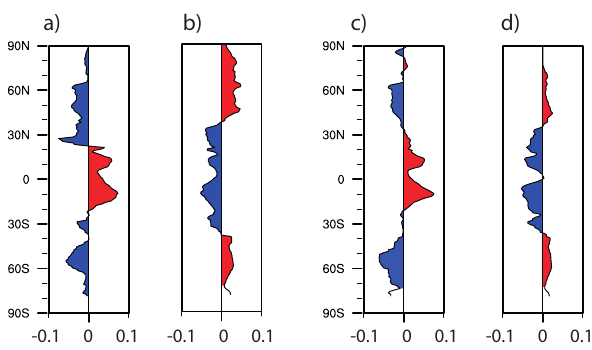
Fig. 5. Zonal mean changes in (a) light and (b) nutrient limitation of diatoms and (c) light and (d) nutrient limitation of small phyto- plankton. The limitation factor is a unitless value between zero and one, with zero representing maximal limitation and one represent- ing unlimited growth. An increase in limitation factor leads there- fore to an increase in growth. For this plot, changes in the limitation factor have been calculated for each cell as described in Sect. 2.5, and the zonal means of the resulting changes are